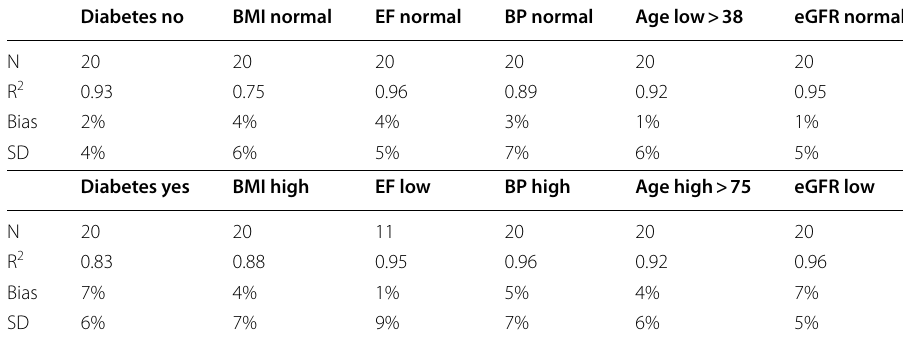
Values are mean SD. The results are based on the reference PBIF ±